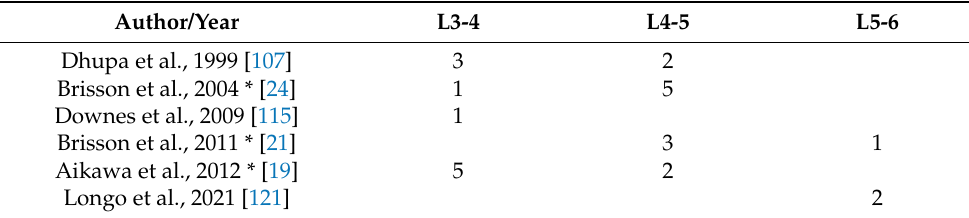
Table 5. Number and sites of recurrences on IVD spaces on caudal lumbar area.